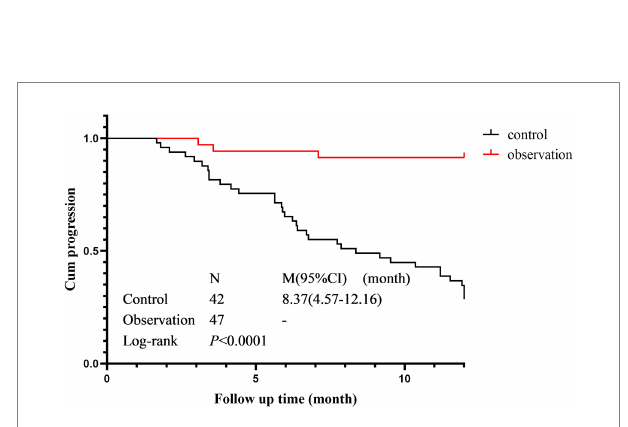
FIGURE 4 Cumulative progression rate in the observation group and control